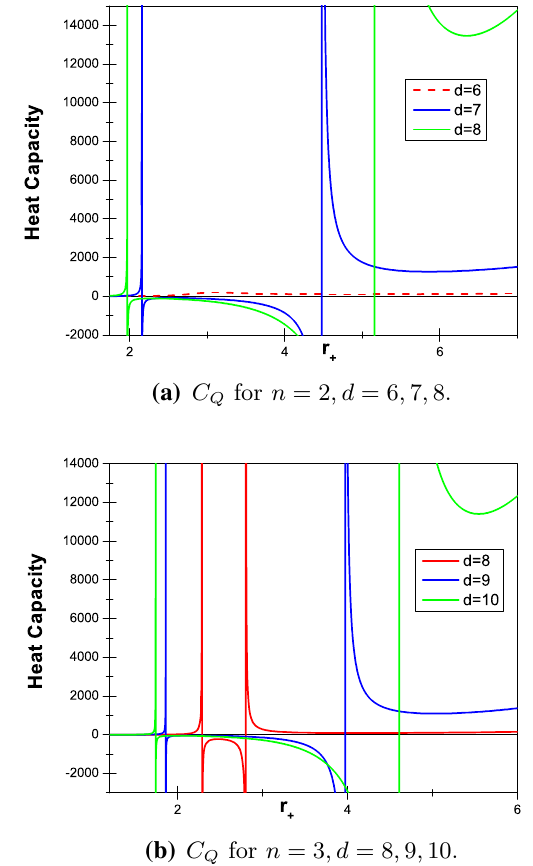
Fig. 6 C Q for second family of solutions with toy values of Q = 1 and l =